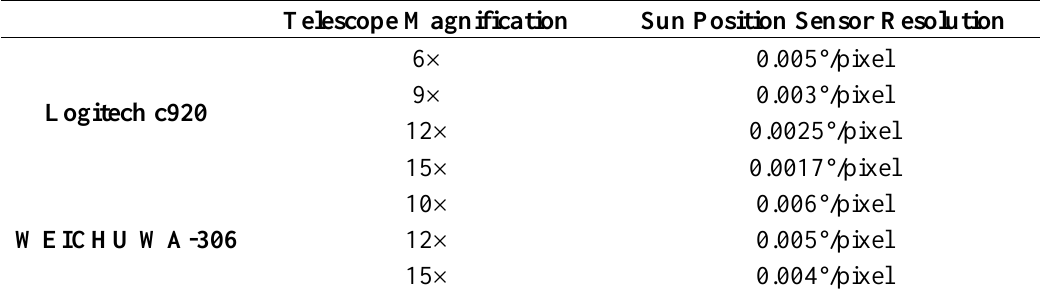
Table 1. Sun position sensor resolution in each